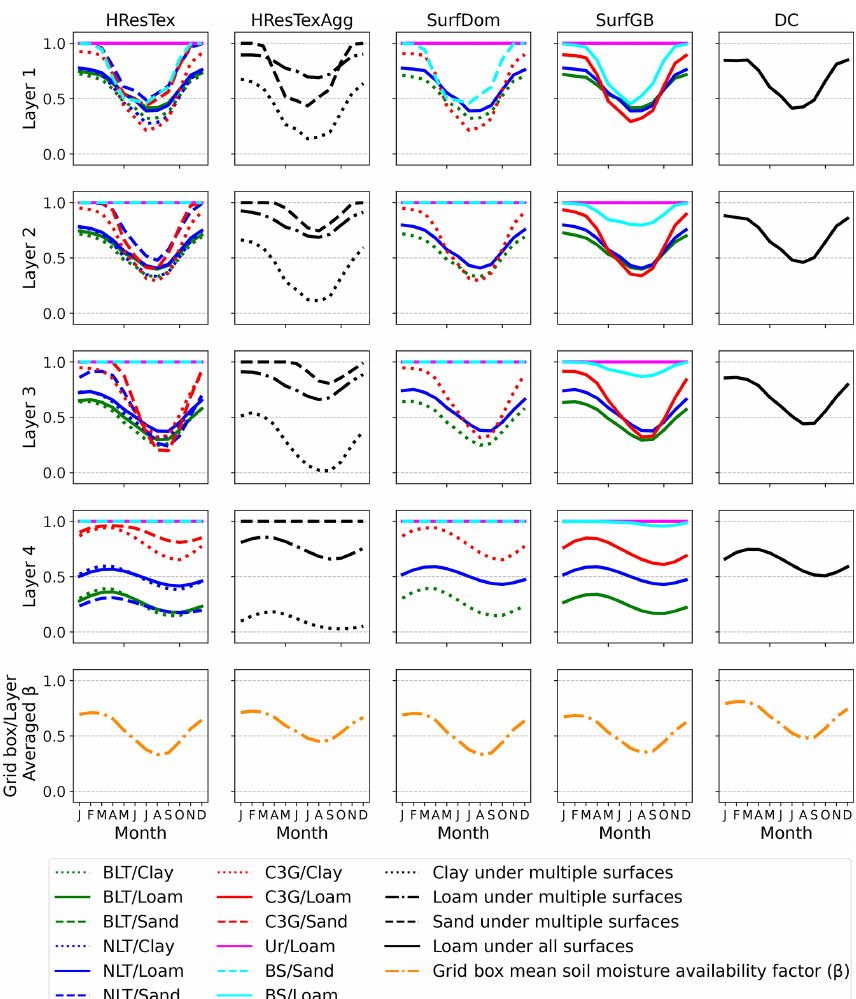
Figure 4. Mean annual cycles for soil moisture availability factor ( β ). Each row corresponds to a soil model level. Colours represent surface tiles, and line styles represent the soil tile type. For HResTexAgg, there are multiple surface types for each soil type (as per Fig. 2e); hence lines are black and soil tiles are represented by line styles. Final row shows the grid box mean and layered average β